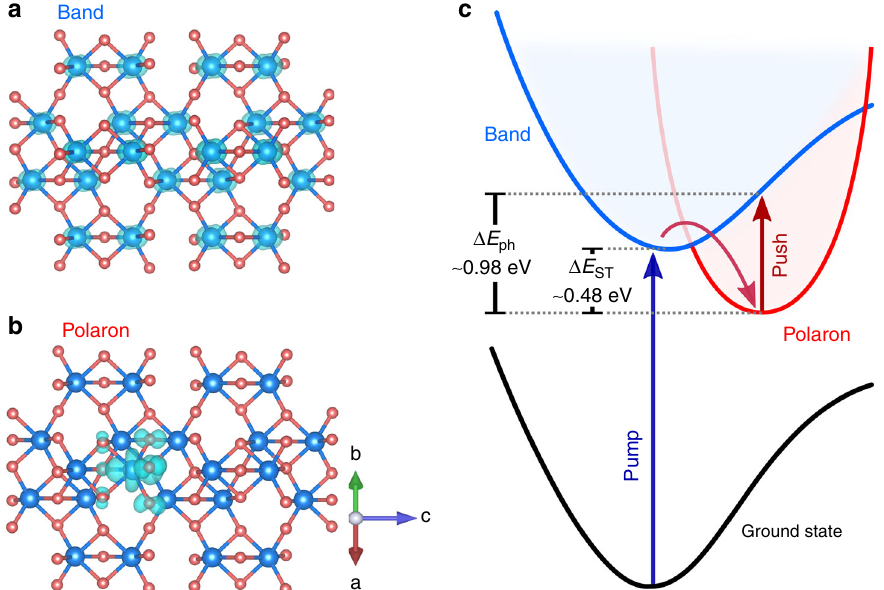
Fig. 1 Excess charge localisation and delocalisation in α -Fe 2 O 3 : spin density associated with an excess electron in Fe 2 O 3 in ( a ) a delocalised band state spread over equivalent Fe atoms and ( b ) a small-polaron state forming a single Fe(II) species. c The potential energy surface for the ground and excited states showing the absence of a barrier for polaron formation (see the Methods section for